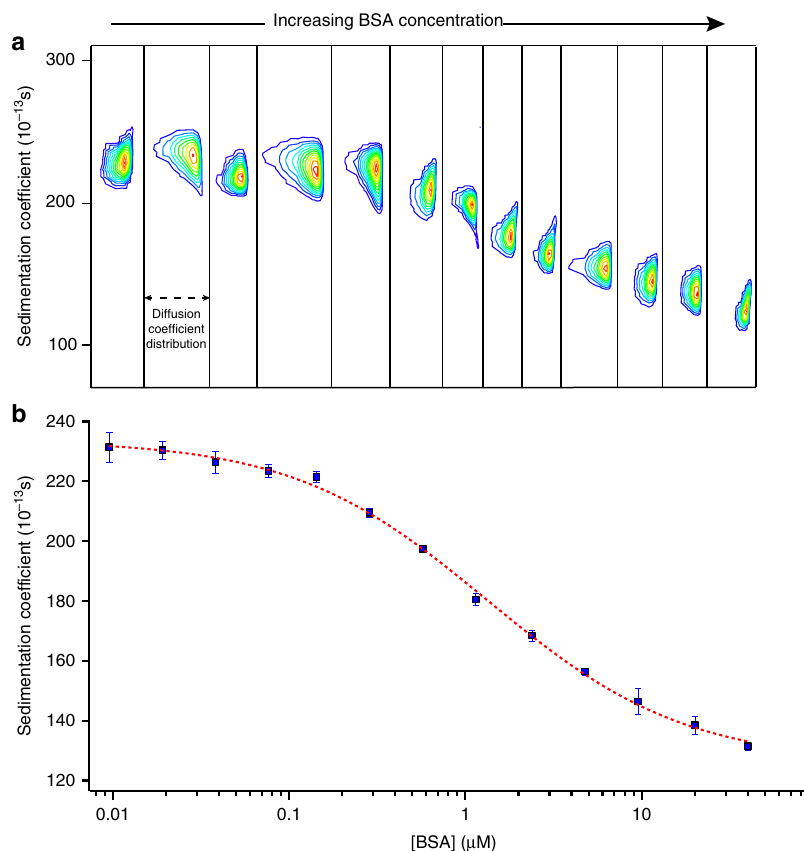
Figure 1 | SV–AUC experiments for MUA–AuNPs with BSA. ( a ) Concentration contour graphs of 2D- c ( s , D ) analysis with the y axis representing the sedimentation ( s ) values. ( b ) A plot showing the average s values (blue squares) of each individual graphs shown in ( a ) plotted against the protein concentration. The red dashed line is the fit function obtained using equation (6). Error bars represent the s.d. of three independent experiments from the same batch of NPs.